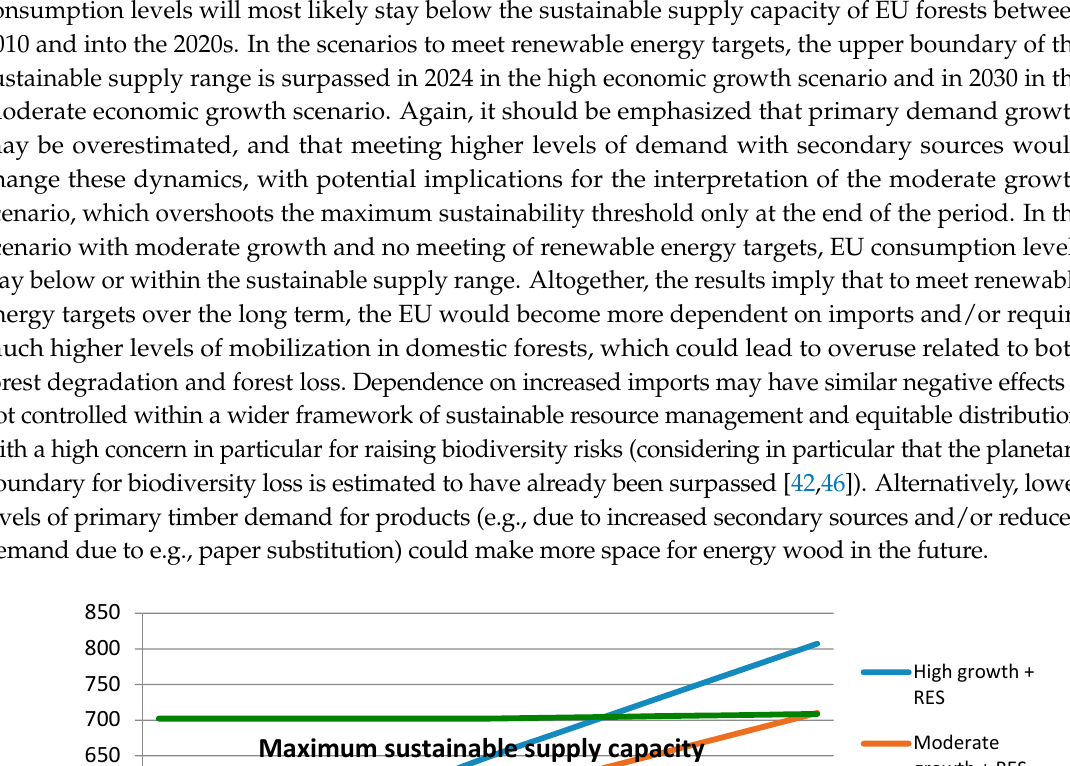
Figure 3. Scenarios of global and EU per capita consumption of primary timber under different assumptions regarding economic growth and fuelwood use, 2010–2050. Note: based on [18,19,35,39].